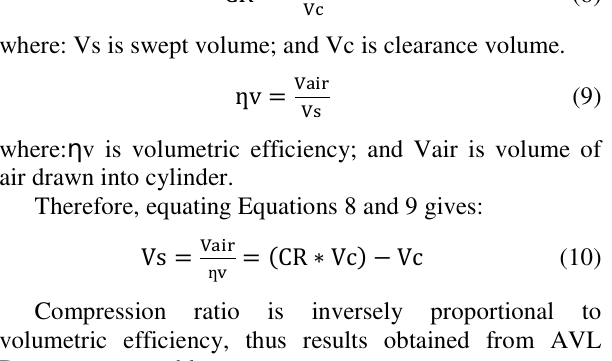
proportional to the rotational speed (i.e. engine speed).